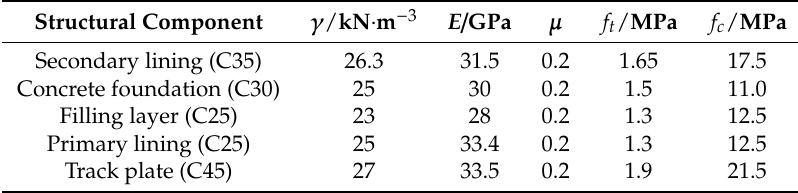
Table 2. Structural mechanical parameters (e.g., lining and track plates).